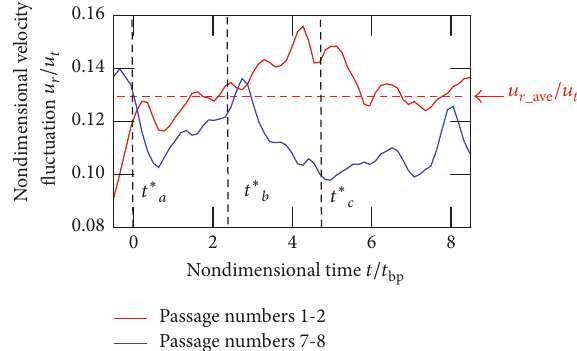
Figure 8: Radial velocity fluctuation measured at diffuser inlet